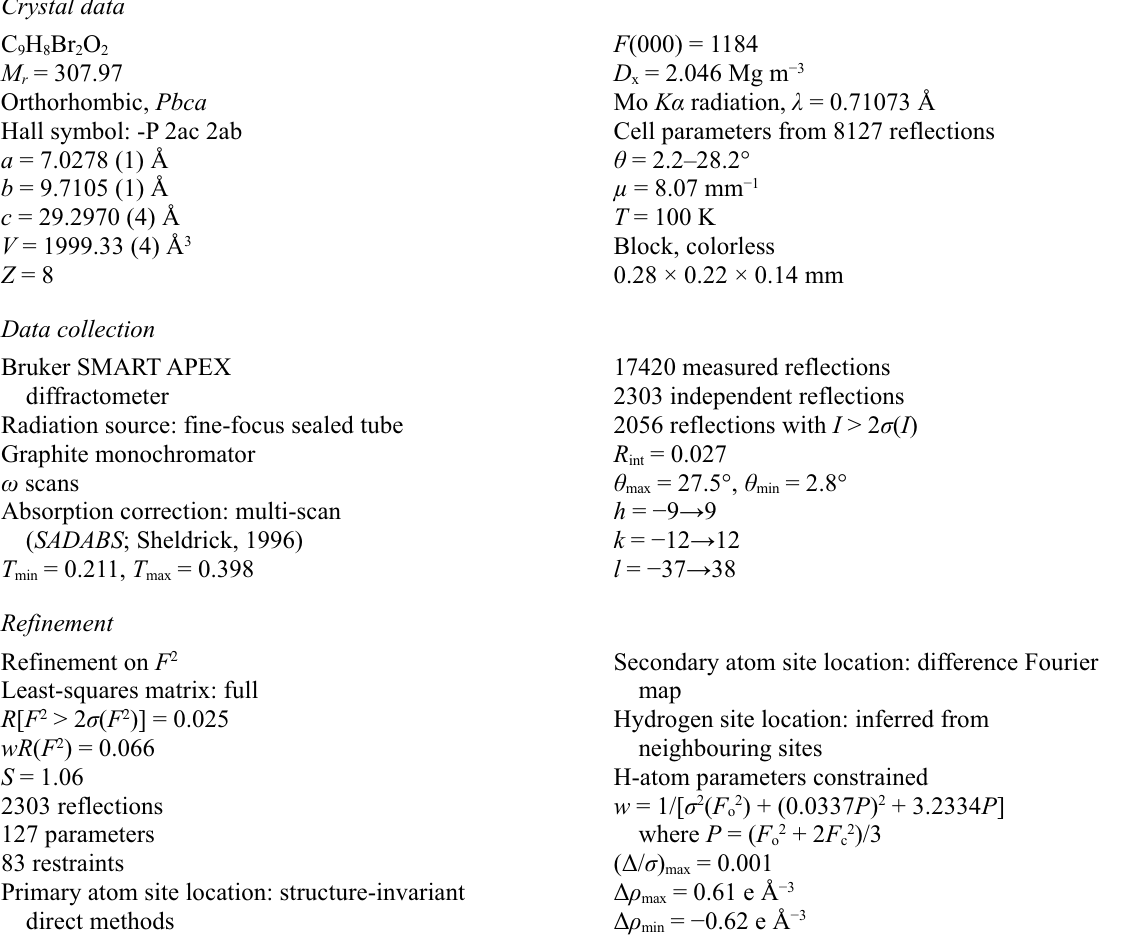
H Br O . Hydrogen atoms are drawn as spheres of arbitrary 9 8 2 2